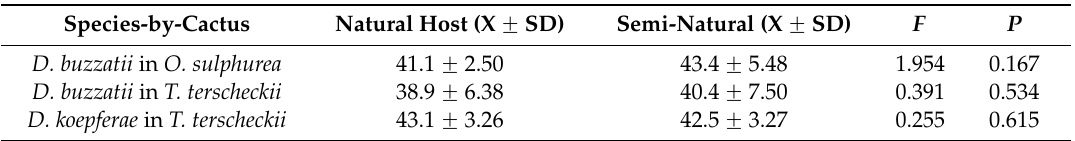
Table 4. Mean ovariole number (X) and standard deviation (SD) in females emerging from natural hosts and reared on semi-natural